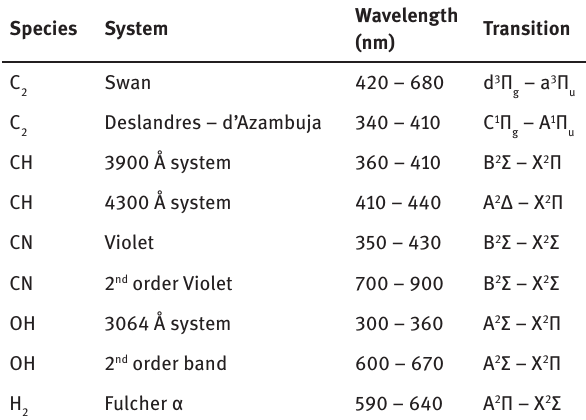
Table 2 : Identified radiative molecular systems.